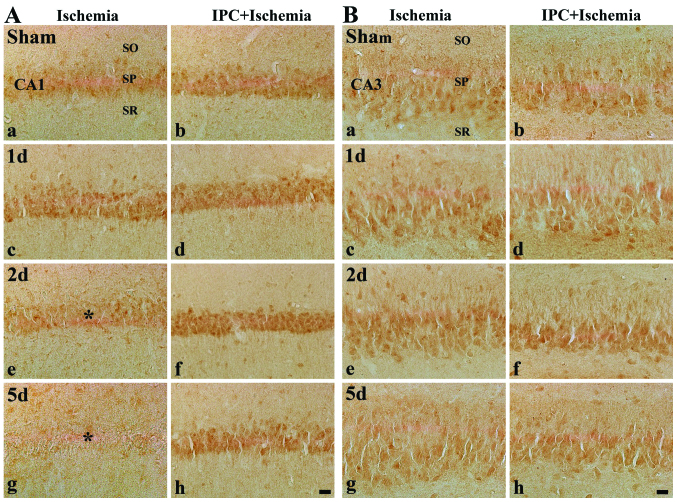
Immunohistochemistry for KYNA in (A) the CA1 region and (B) CA2/3 region of the ischemia-operated (first and third columns) and IPC + ischemia-operated (second and fourth columns) groups at (a and b) sham, (c and d) 1 day (1 d), (e and f) 2 days (2 d) and (g and h) 5 days (5 d) following ischemia-reperfusion. KYNA immunoreactivity was easily detected in the stratum pyramidale (SP) in the sham-operated group. In the CA1 region, KYNA immunoreactivity in the SP (asterisk) was increased at 1 day post-ischemia, decreased at 2 days post-ischemia and markedly decreased (reached its lowest level) at 5 days post-ischemia. However, in the IPC + sham-operated group, KYNA immunoreactivity was similar to that in the sham-operated group, and the immunoreactivity was increased in the IPC + ischemia-operated group. KYNA immunoreactivity in the SP of the CA2/3 region was not significantly altered in all groups. KYNA, kynurenic acid; CA1, region I of hippocampus propern; IPC, ischemic preconditioning; SO, stratum oriens; SR, stratum radiatum. Scale bar, 50 μm.